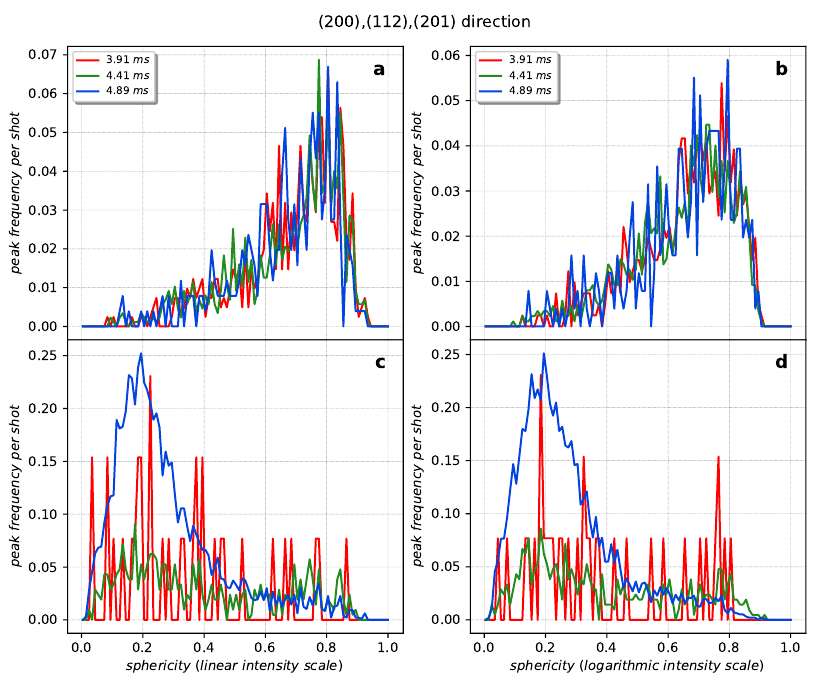
Figure A9. Frequency of a peak appearing with a certain sphericity for the (200), (112) and (201) directions for the hits above 50 ADU/pixel ( a ) in linear and ( b ) in logarithmic intensity scales as well as the hits below 50 ADU/pixel ( c ) in linear and ( d ) in logarithmic intensity scales.